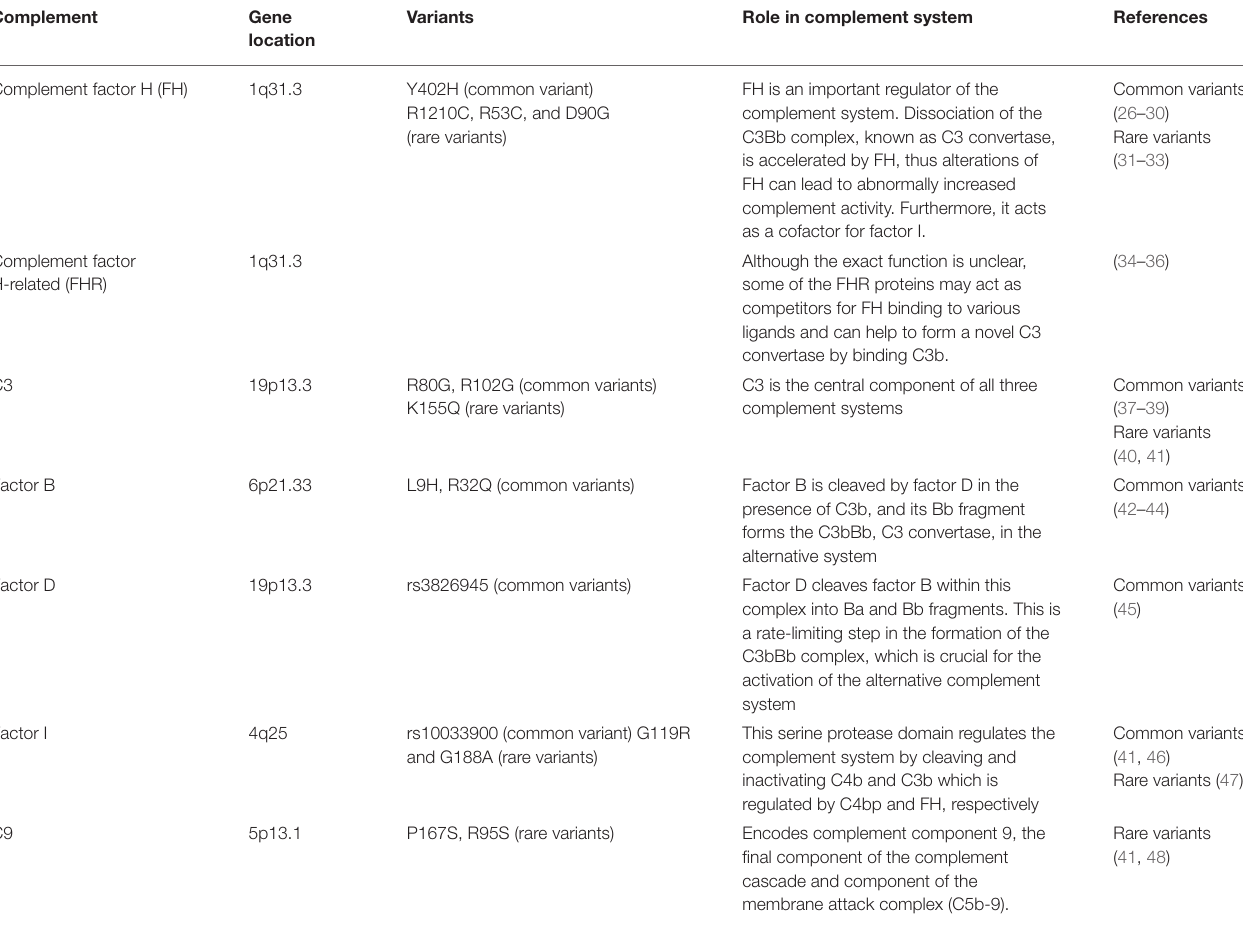
TABLE 1 | Genes in the alternative complement pathway that are involved in age-related macular